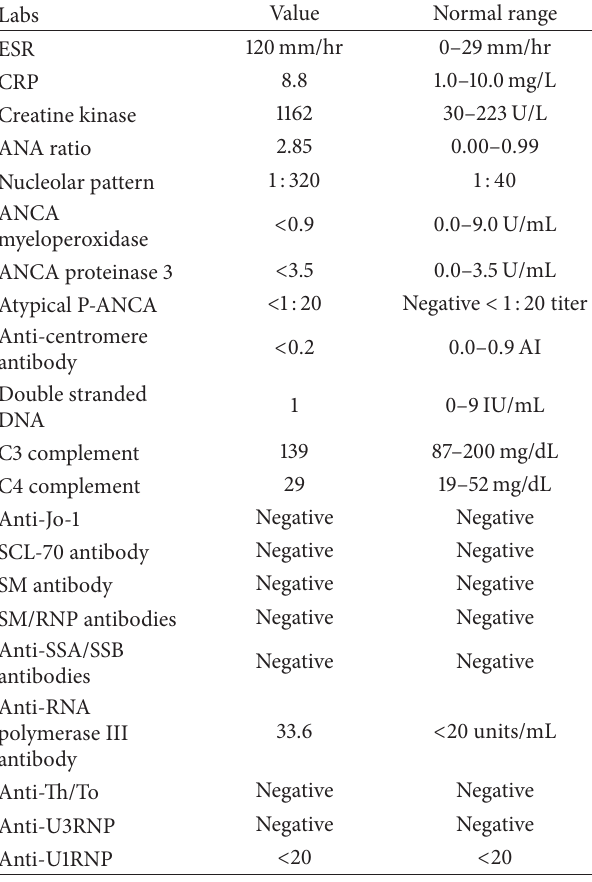
Table 1: Autoimmune laboratory results.